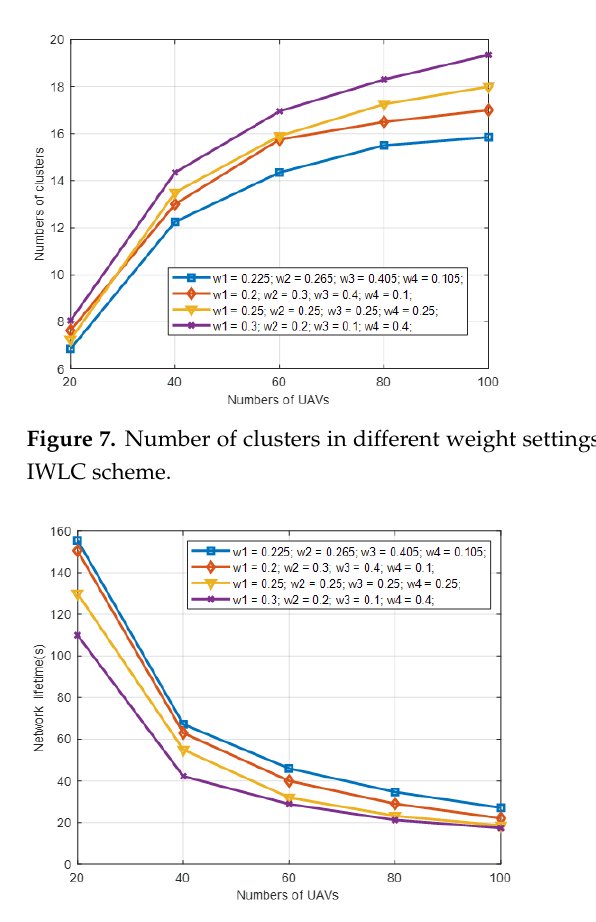
Table 4. Four sets of weight settings .